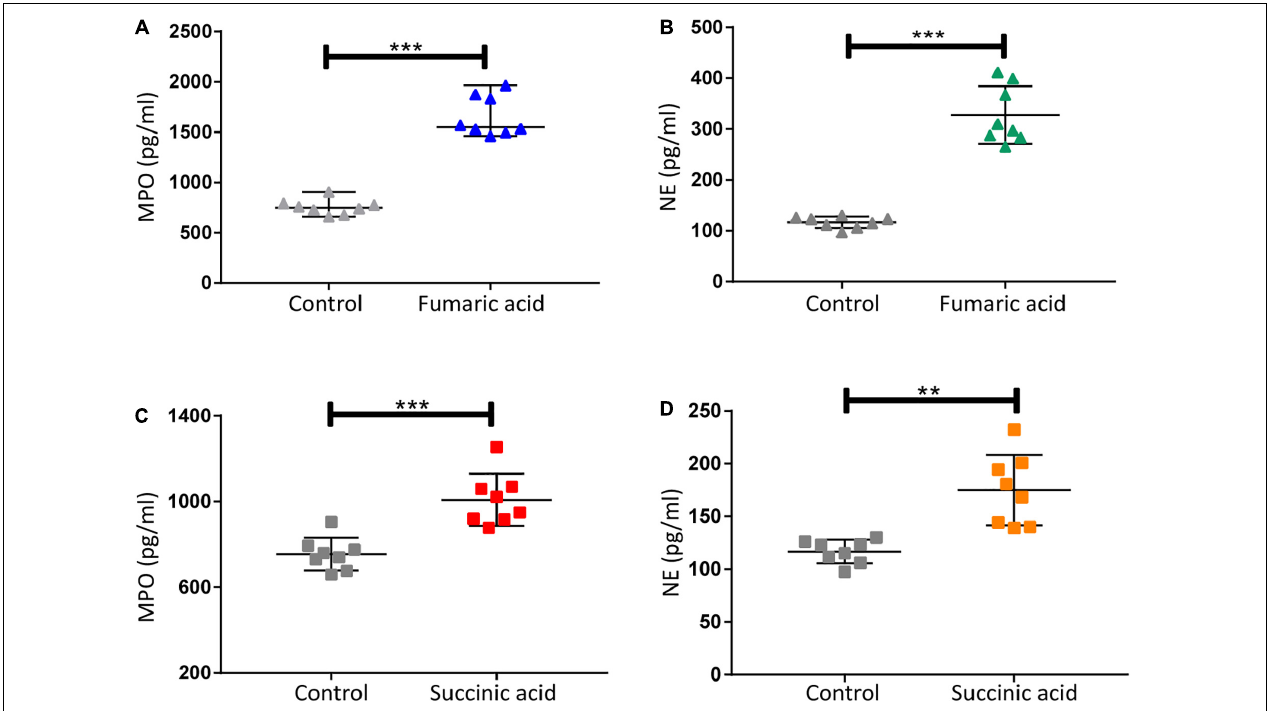
FIGURE 5 | Fumaric acid or succinic acid can promote formation of NETs. (A,B) Quantification of MPO and NE in the supernatants of neutrophils from normal mice treated with fumaric acid or DMSO as control ( n = 8/group; mean ± SD; *** p < 0.001; Differences were assessed by Unpaired t-test). (C,D) Quantification of MPO and NE in the supernatants of neutrophils from normal mice treated with succinic acid or DMSO as control ( n = 8/group; mean ± SD; *** p < 0.001, ** p < 0.01; Differences were assessed by Unpaired t